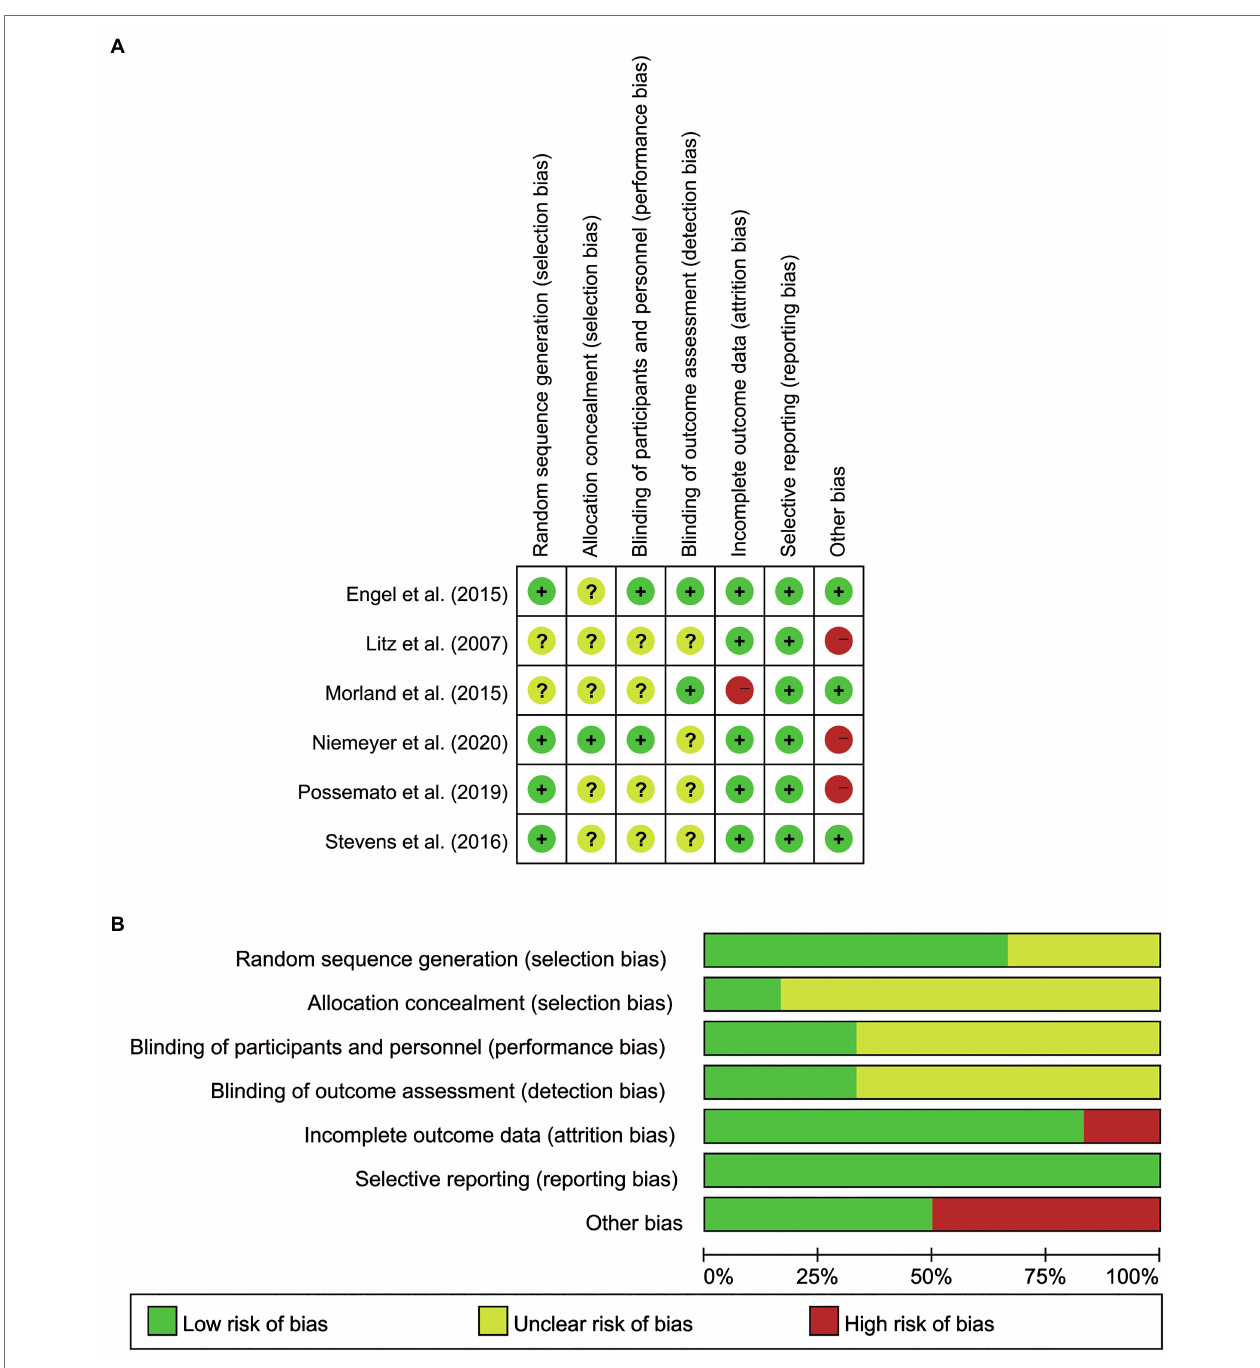
FIGURE 2 | (A) Summary of Risk of Bias for all the included studies. (B) Graph of Risk of Bias for all the included